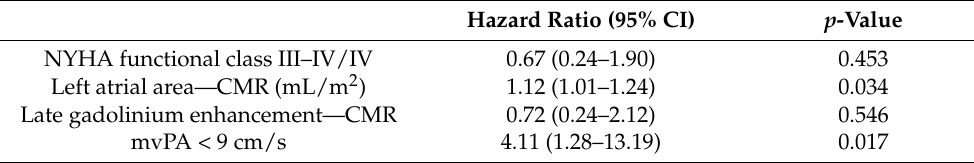
Table 4. Multivariate regression analysis.